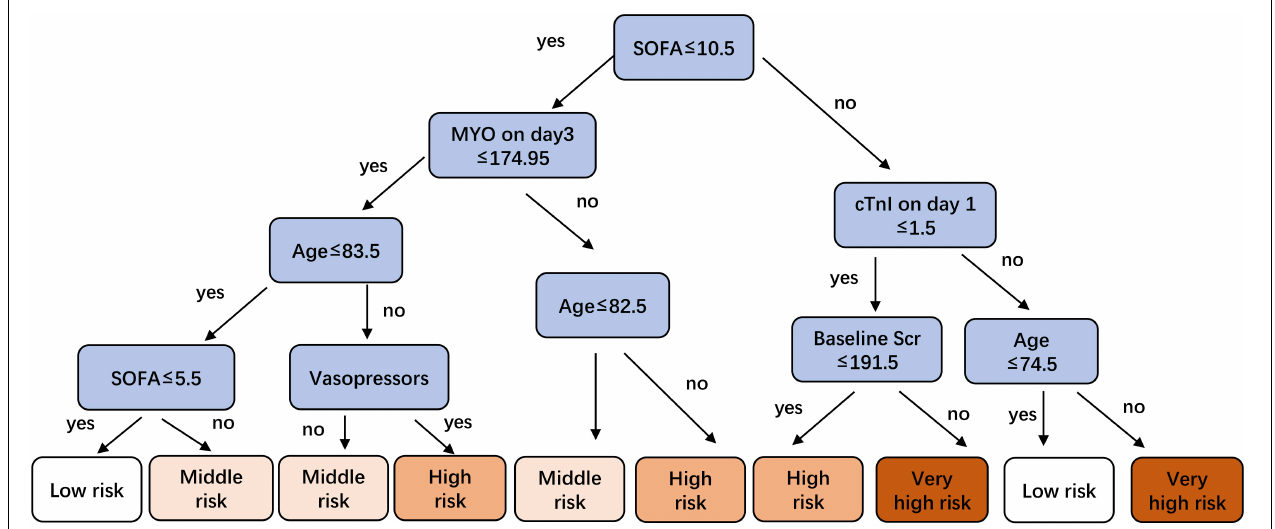
FIGURE 8 | A pruned decision tree for predicting risk stratification of 1-year mortality in sepsis-induced CRS